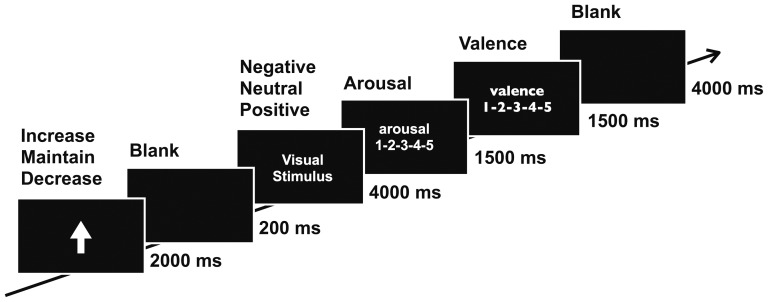
Timeline of the cognitive reappraisal task.Three regulatory instructions—increase, maintain, and decrease—were indicated by the up-arrow, dash, and down-arrow, respectively. After a 200 ms blank period, a 4000 ms visual emotional stimulus appeared for the cognitive reappraisal task. For the arousal and valence rating of the stimulus, two 5-point scale screens followed for 3000 ms each.